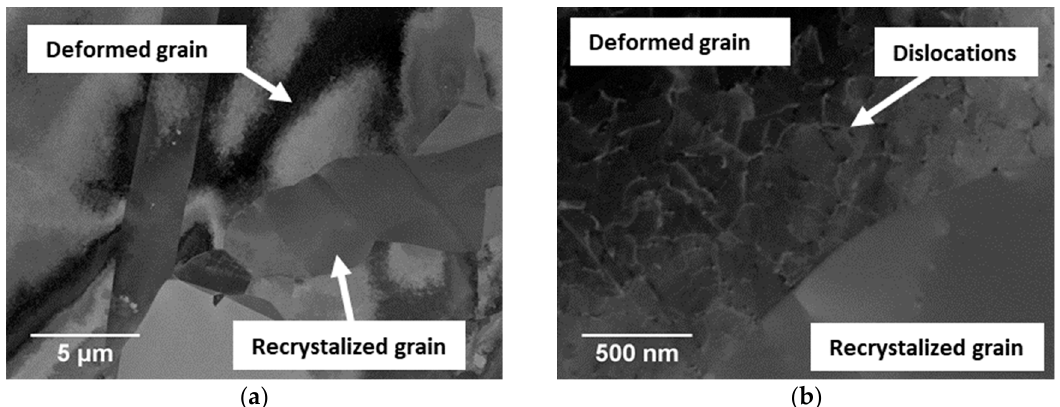
Figure 3. ECCI image of plate hot rolled at 1050 °C with a deformation level of 23.5% showing deformed grains and recrystallized grains ( a ). A large number of dislocations in the deformed grain ( b ).